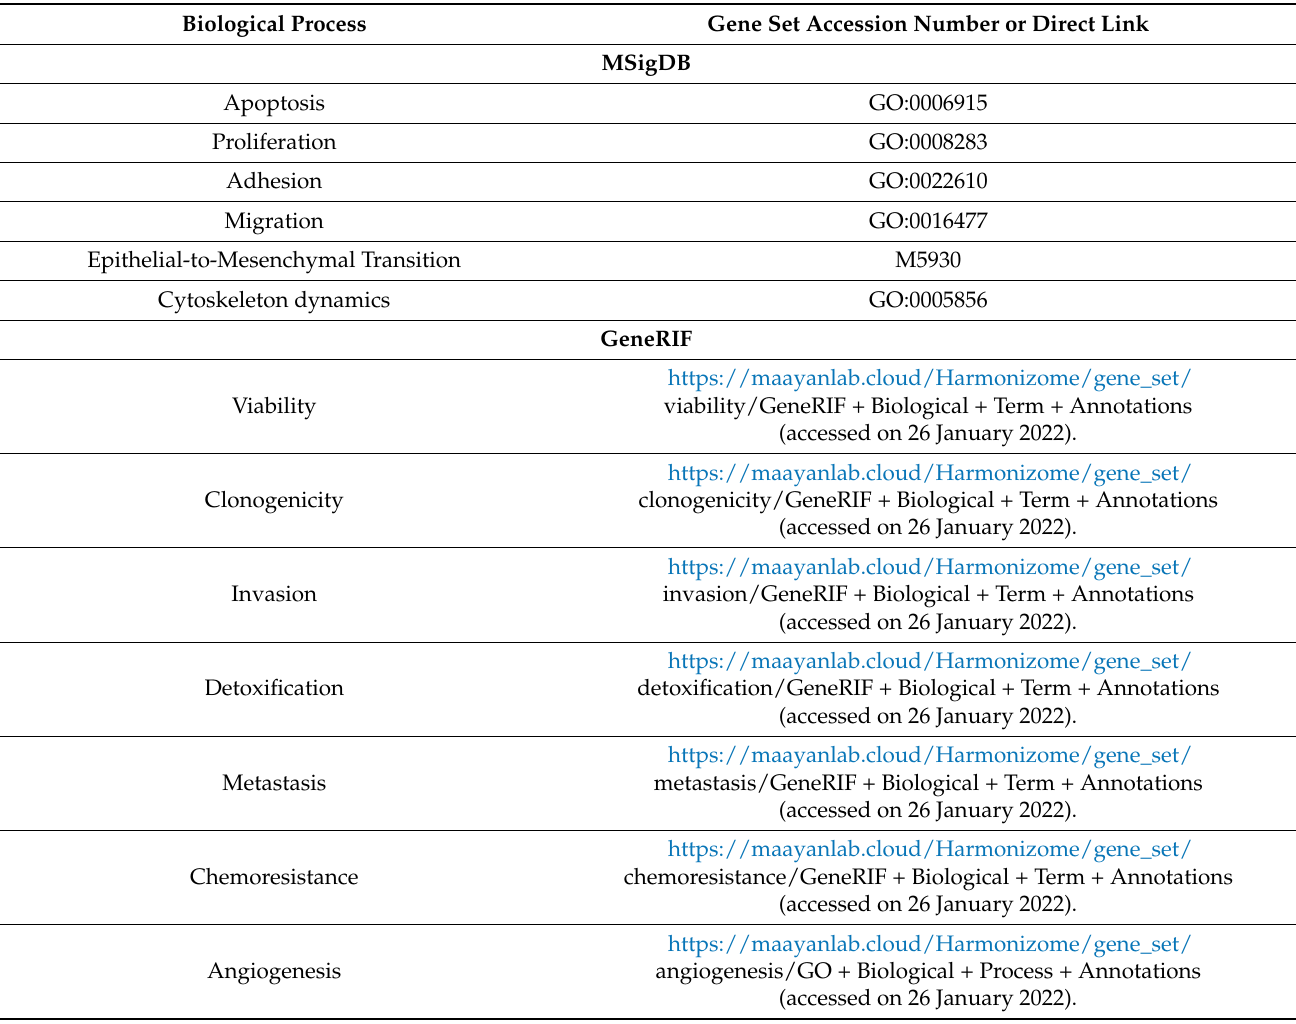
Table 1. Gene sets selected to represent biological